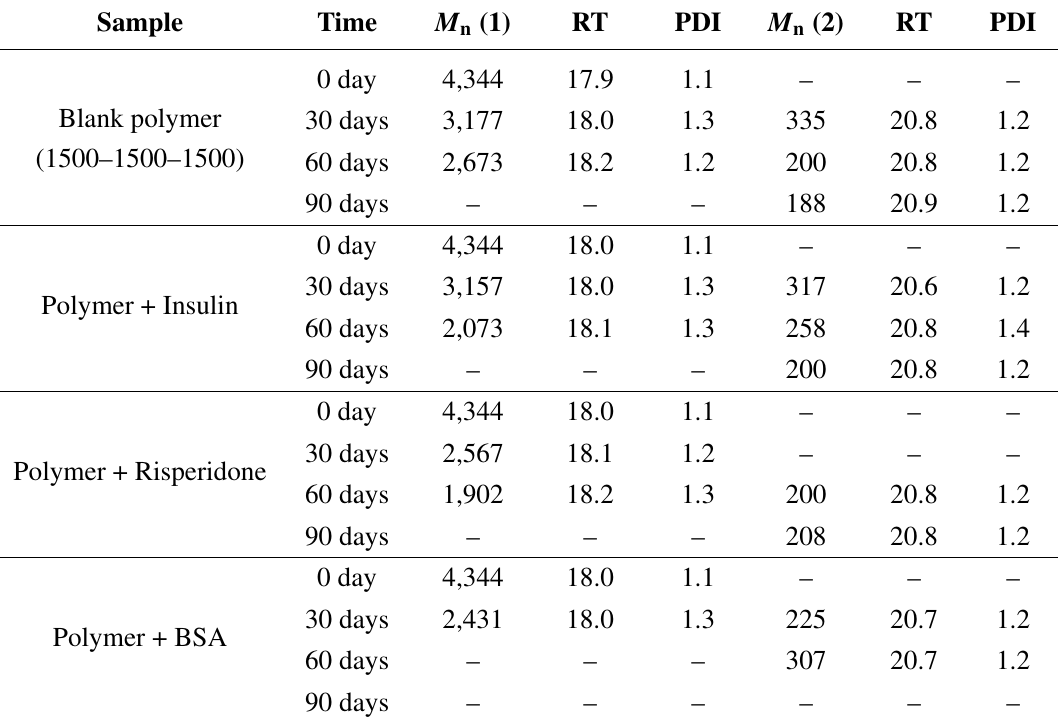
Table 1. Molecular weight of the polymer PLA–PEG–PLA (4500 Da) remaining after hydrolytic degradation in phosphate buffer saline (PBS), pH 7.4 at 37 ˝